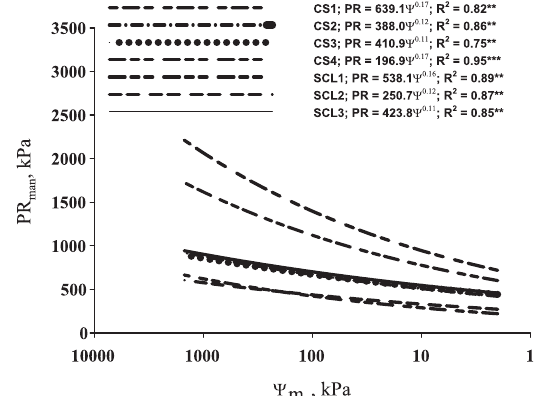
Figure 2. Soil penetration resistance (unconfined strength) measured with a pocket manual penetrometer, varying water tension.